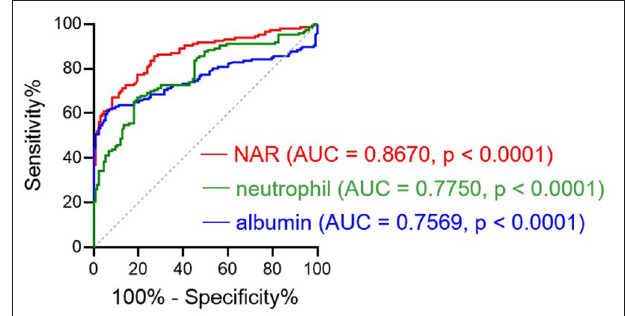
FIGURE 1 | Receiver operating characteristics (ROC) curve analysis. The performances of the neutrophil-to-albumin ratio (NAR), blood neutrophil percentages, and serum albumin levels to discriminate ulcerative colitis (UC) from controls were determined by ROC curve analysis. AUC, area under the ROC curve. p < 0.05 was considered significant. UC, n = 146; Controls, n =